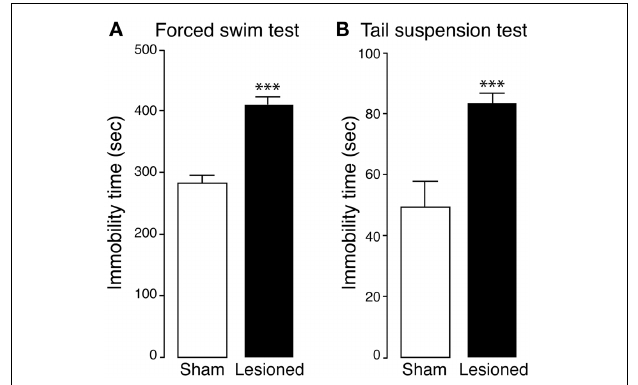
FIGURE 3 | Depression-like phenotype in 6-OHDA-lesioned mice. Sham and 6-OHDA-lesioned (Lesioned) mice were tested for depression-like behavior in the forced swim test (A) and tail suspension test (B) . Bar graphs show the immobility time (s) of sham and 6-OHDA-lesioned mice, during the forced swim test ( A ; test duration, 10min, sham n = 12, lesioned n = 15) and the tail suspension test ( B ; test duration 6min, sham n = 15, lesioned n = 12). Data are expressed as mean ± s.e.m. ∗∗∗ p < 0 . 0001 vs. sham mice, Student’s t -test.